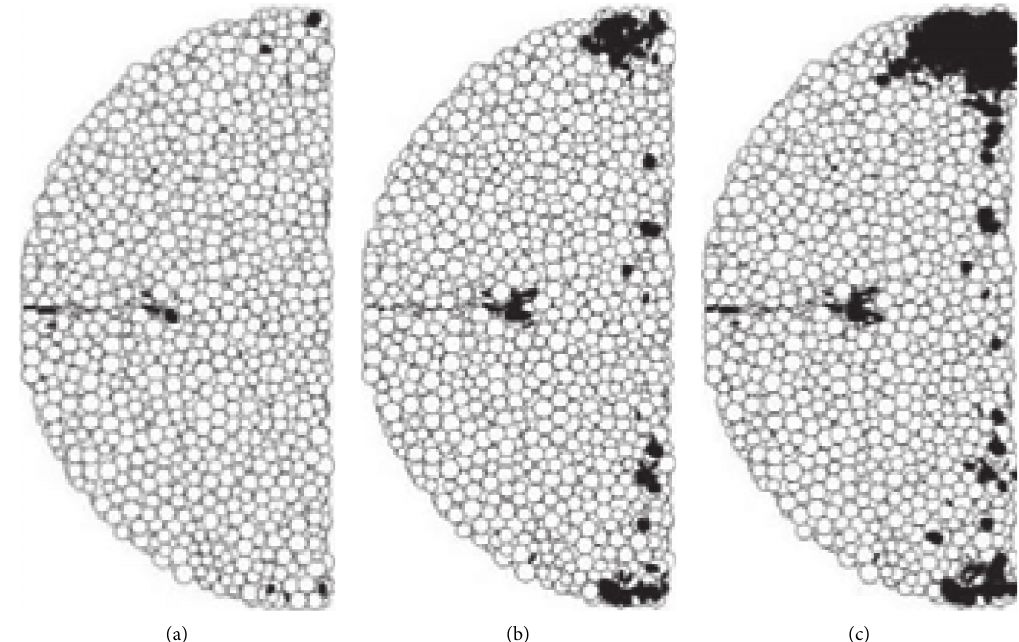
Figure 18: Microcracks distribution in ECFSD specimen (C2). (a) Crack initiation. (b) Crack growth. (c) Sample failure.